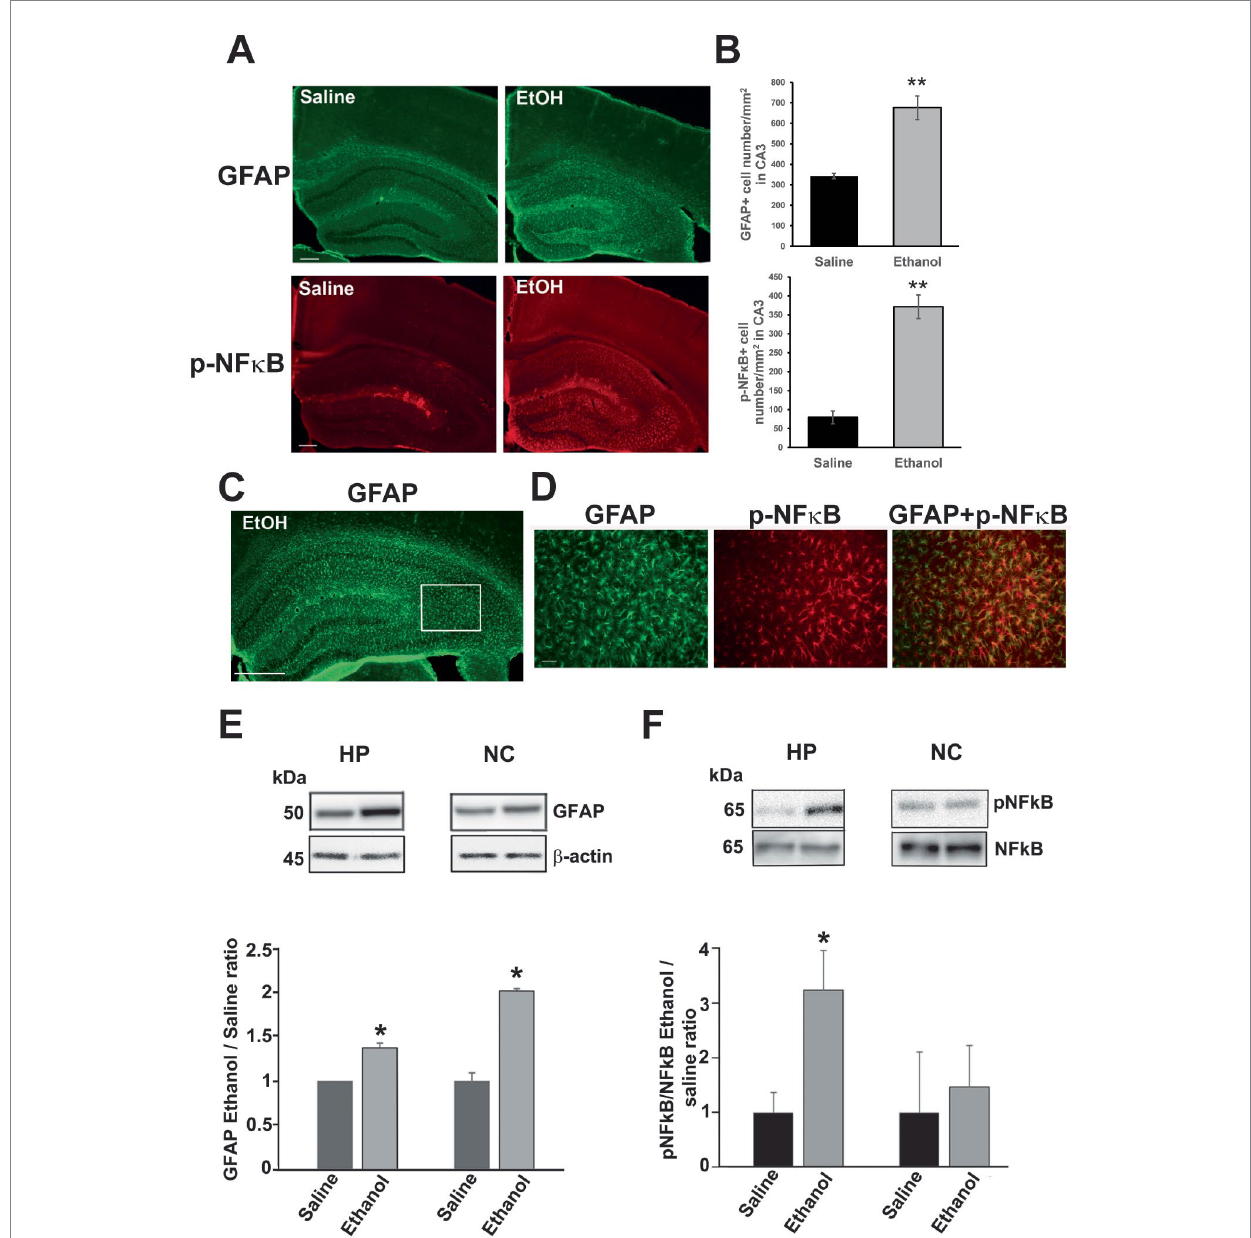
FIGURE 5 P7 ethanol increases GFAP and p-NF κ B P65 levels at P90. (A) Mice injected with saline or ethanol at P7 were perfusion-fixed at P90, and the brain sections were immunostained by anti-GFAP antibody and anti-phospho-NF κ B P65 (p-NF κ B) antibody. Scale bar = 200 μ m. (B) From the images, such as shown in A , GFAP+ and p-NF κ B+ cell densities were measured in the dorsal hippocampal CA3 region. ** p < 0.01 between saline and ethanol groups by Student’s t -test. n = 4. (C,D) Brain sections were dual-labeled with anti-GFAP antibody (green) and anti-p-NF κ B antibody (red), and the images were overlaid. A rectangular region with white line (a part of the dorsal hippocampal CA3) in C was enlarged and shown in D . Scale bar = 500 μ m in C and 50 μ m in D . (E) Mice injected with saline or ethanol at P7 were sacrificed at P60, and the hippocampus (HP) and neocortex (NC) samples were used for Western blot analyzes of amounts of GFAP. The amounts of GFAP were normalized to actin and the ratio of ethanol/saline was calculated. *Significantly different by Student’s t -test. n = 4. (F) Similarly, the effects of P7 ethanol on pNFĸB expression were examined in hippocampus and cortex, The ratios of pNFĸB and NFĸB were compared as the ratios of ethanol/saline. * p < 0.05 by Student t -test. n =